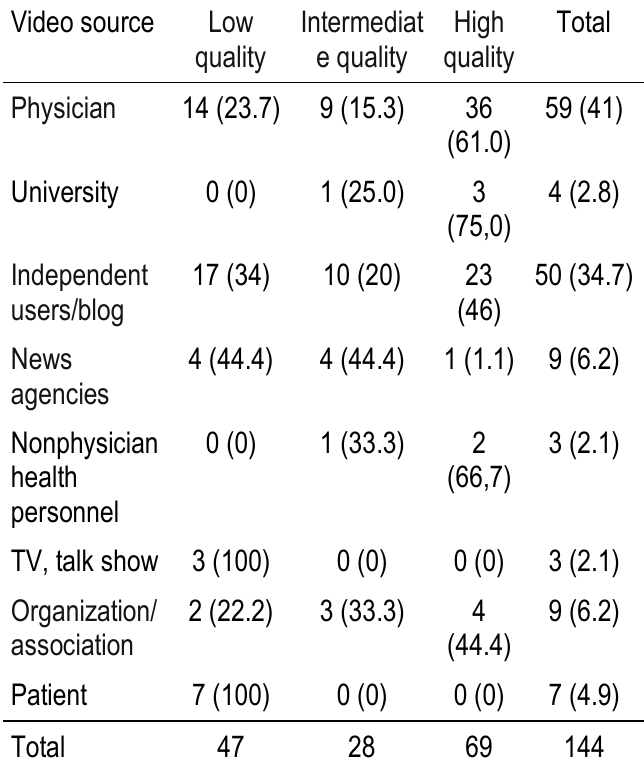
Table 3. Quality categorization of the videos according to video sources, n